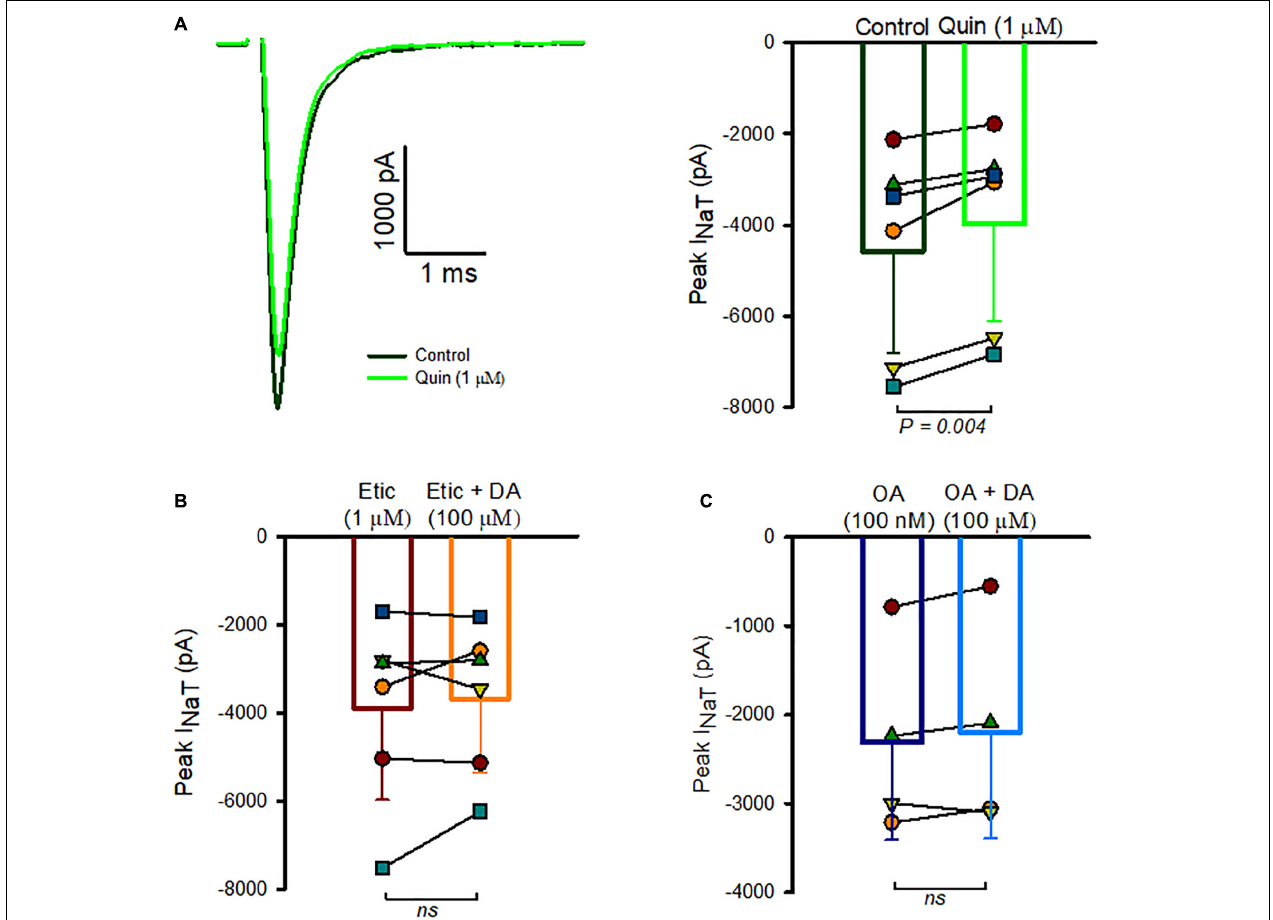
FIGURE 3 | Role of D2-like receptors in I NaT inhibition. (A) Whole cell currents in an isolated calyx in control (black trace) and following quinpirole perfusion (green trace) are shown in response to a voltage step to –40 mV (left panel). P23 calyx, male. Box plot indicates the response of 6 calyces to quinpirole (right panel). Mean I NaT control was –4,573 ± 2,247 pA, mean I NaT in quinpirole was –3,978 ± 2,132 pA, n = 6, ages P19-28, P = 0.004). (B) Na + currents were measured in the presence of 1 µ M eticlopride, followed by perfusion of 1 µ M eticlopride and 100 µ M dopamine. Peak Na + currents averaged –3,895 ± 2,083 pA in eticlopride which was not significantly different from peak currents in eticlopride and dopamine (–3,680.2 ± 1,679 pA, n = 6, P = 0.985). (C) Summary of the effect of okadaic acid (OA) in reducing the response of I NaT to DA. Mean peak current measured at voltage steps to –40 mV was –2,268 ± 1,170 pA in the presence of internal OA and –2,270 ± 1,061 pA following dopamine perfusion ( n = 4 cells, all P23). In 1 cell, the initial dopamine perfusion resulted in a reduction of I NaT , but following a wash and return to control the cell no longer responded to dopamine application. Data from the second perfusion were used in this